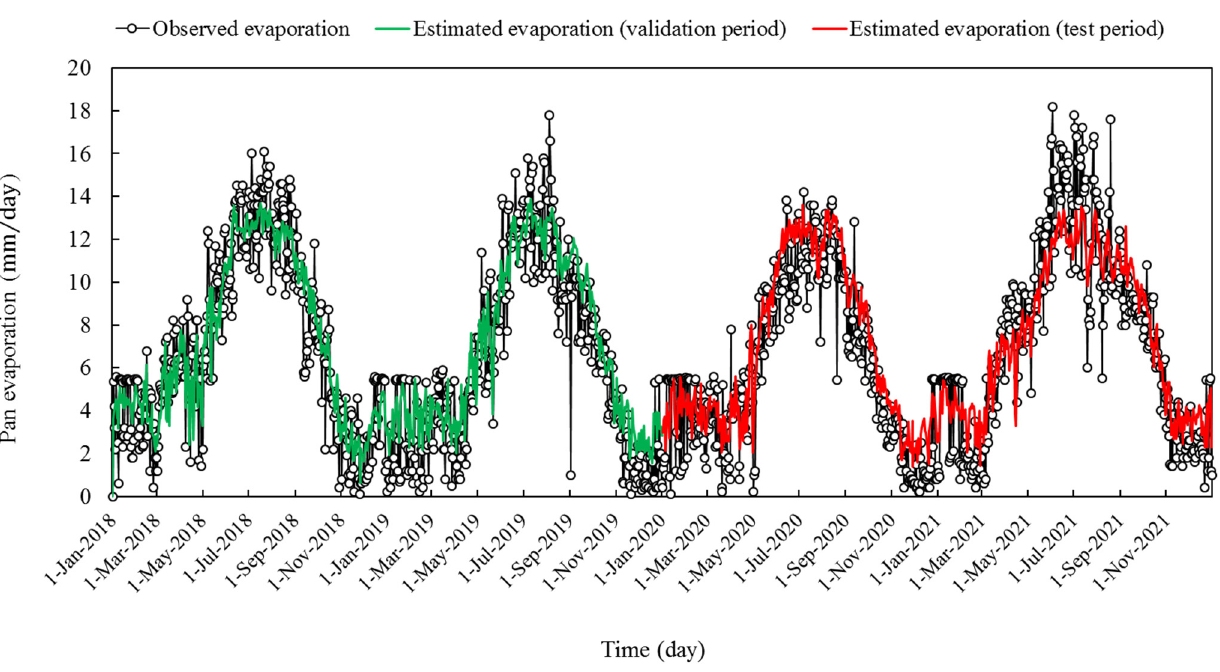
Figure 7. Time series plots of the MLP outputs learned by scaled conjugate gradient algorithm, and the observational pan evaporation.